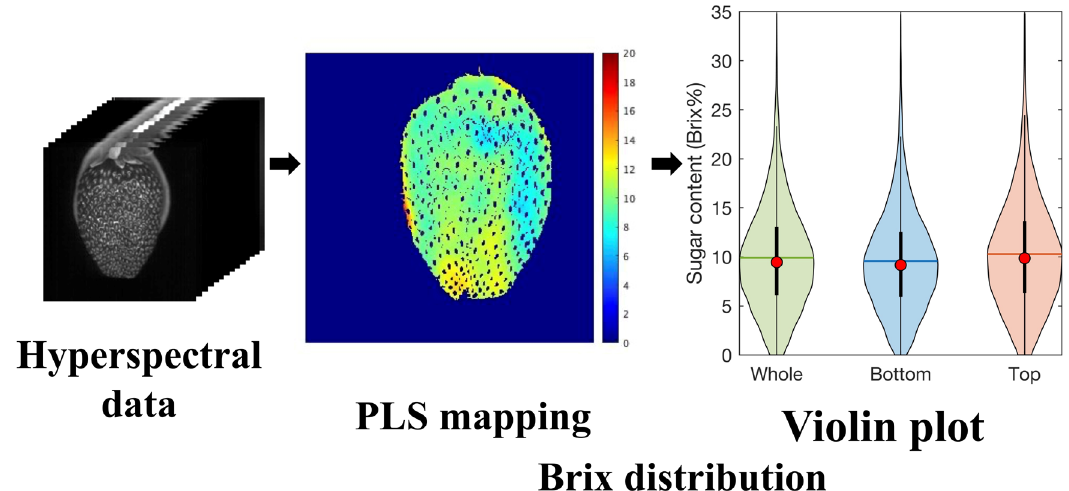
Figure 4. Procedure for visualization of sugar content distribution. Violin plot (colored areas: distribution of data from kernel density estimation; red dots: median; black thick vertical line: interquartile range; horizontal colored lines: mean).